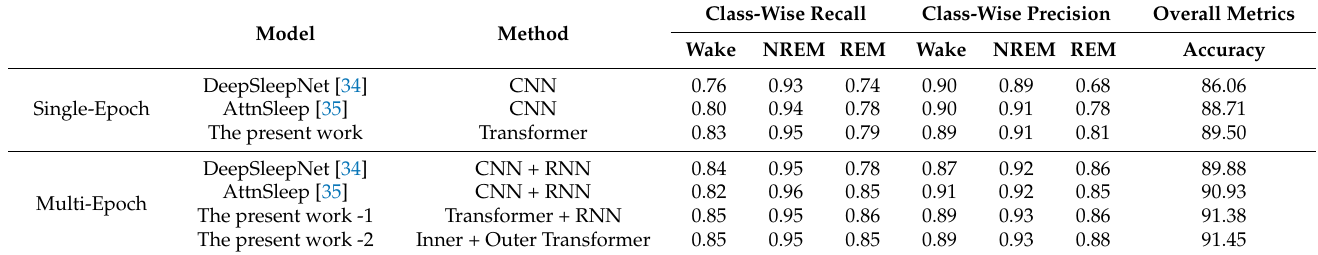
Table 5. Comparison of performance between previous studies and the present